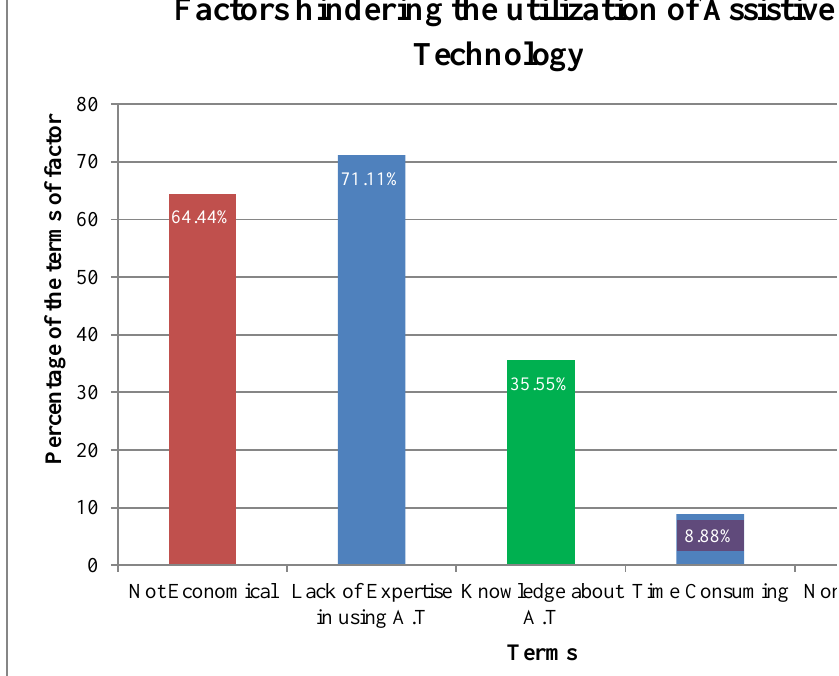
Fig 3. Factors hindering the utilization of Helpful